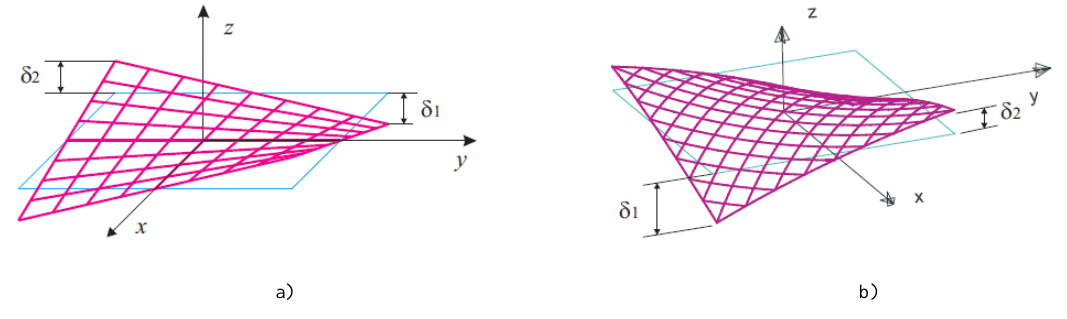
Fig. 2 Cold-twisted square plate: a) hyperbolic paraboloid; b) asymmetric (buckled)